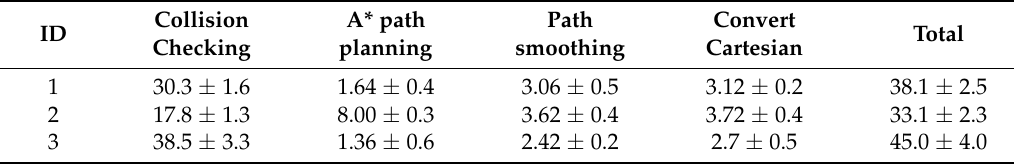
Table 3. Computation time (ms) for path planning in simulations.